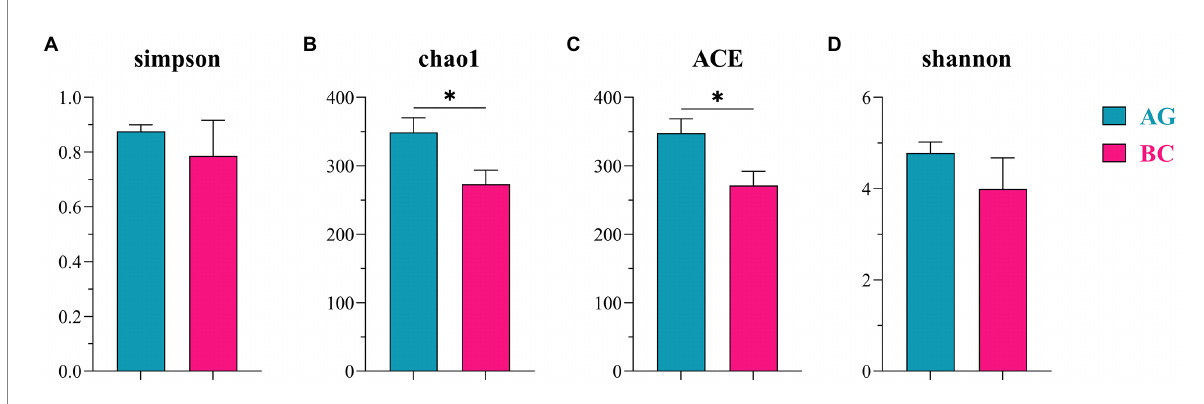
FIGURE 2 Comparison of α -diversity in the gut microbiota between Xinjiang brown cattle (BC) and Angus cattle (AG). ( n = 5 in each breed). Simpson diversity index (A) ; The Chao1 estimator (B) ; The ACE estimator (C) ; Shannon diversity index (D) . Values were expressed as means ± SEM. * denotes P < 0.05 indicating significant difference.